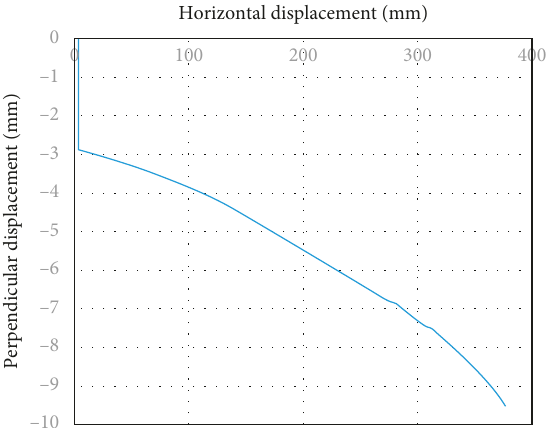
Figure 15: Relationship between vertical displacement and hori- zontal displacement of LNR500.